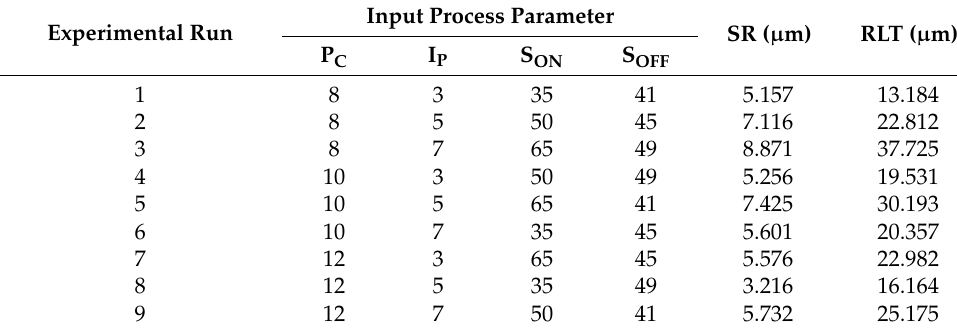
Table 4. L9 Taguchi Orthogonal Design with Output Responses.